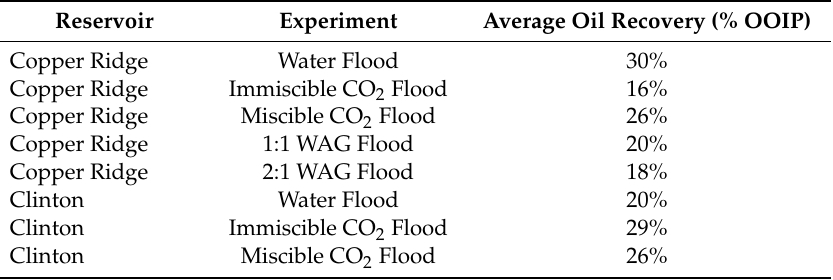
Table 4. Summary of core flooding experiments.